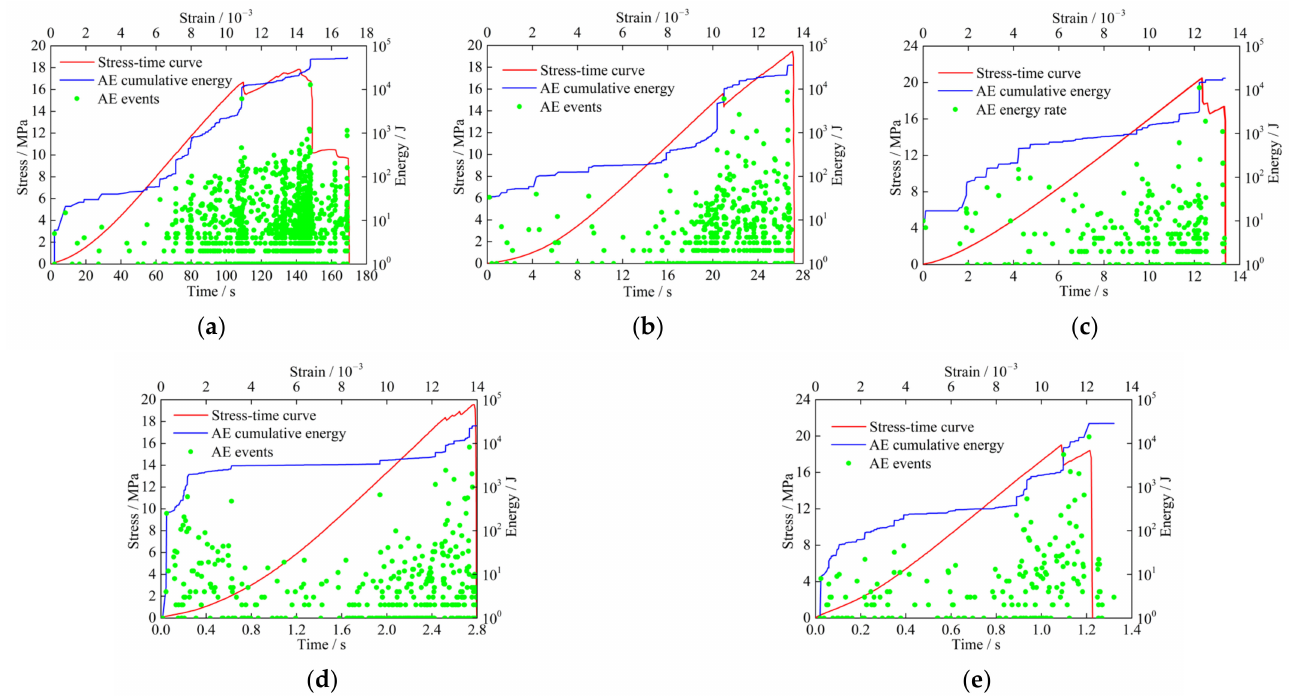
Figure 12. Stress-strain curves and AE characteristics of coal specimens with vertical bedding: ( a ) 10 − 4 s − 1 ; ( b ) 5 × 10 − 4 s − 1 ; ( c ) 10 − 3 s − 1 ; ( d ) 5 × 10 − 3 s − 1 ; ( e ) 10 − 2 s − 1